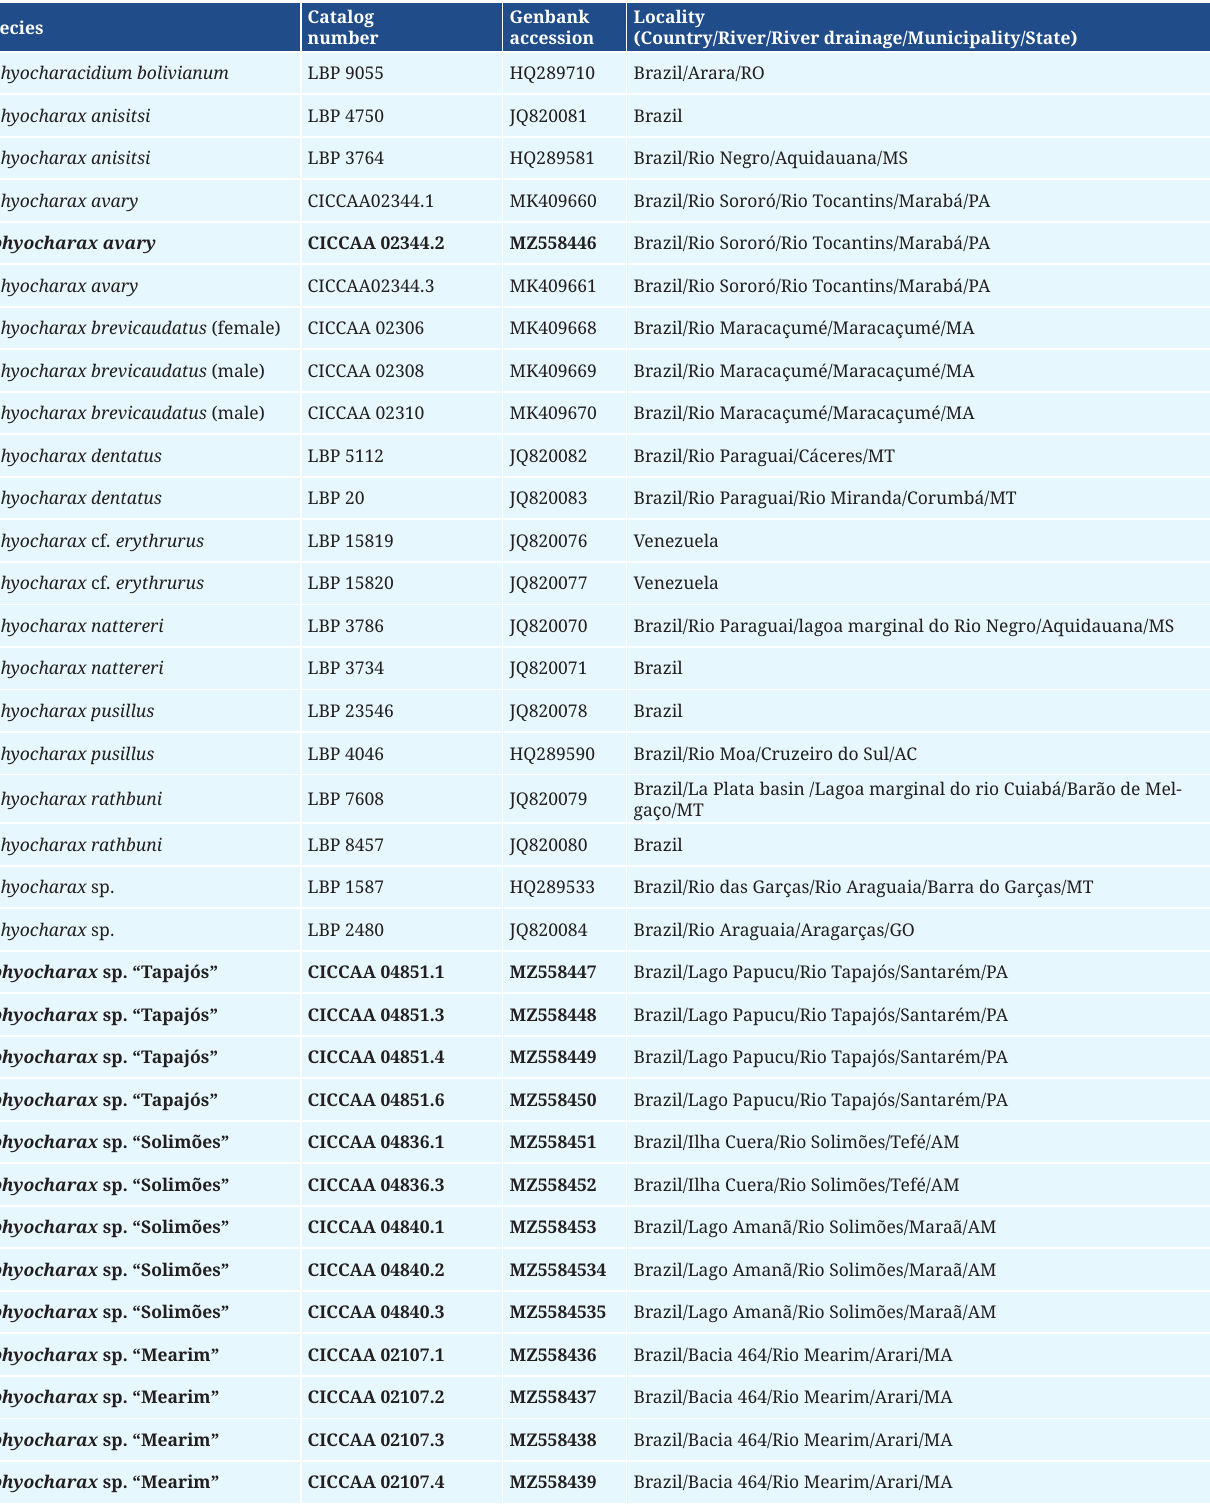
TABLE 1 | List of species, specimens and their respective GenBank sequence accession numbers. Sequences made available by this study are in